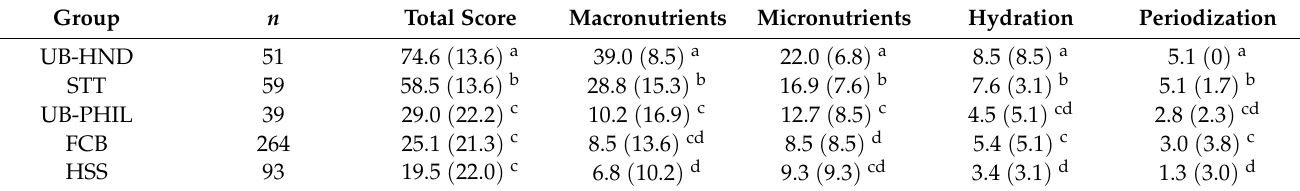
Table 2. Medians (interquartile range) of the NUKYA total and partial scores for the questionnaire subsections in all groups ( N = 506). Different superscript letters indicate statistically significant differences ( p < 0.05). Abbreviations: FCB, athletes of Fútbol Club Barcelona; HSS, high-school students; UB-PHIL, philosophy students; STT, sports technical team; UB-HND, Human and Nutrition Dietetics students.